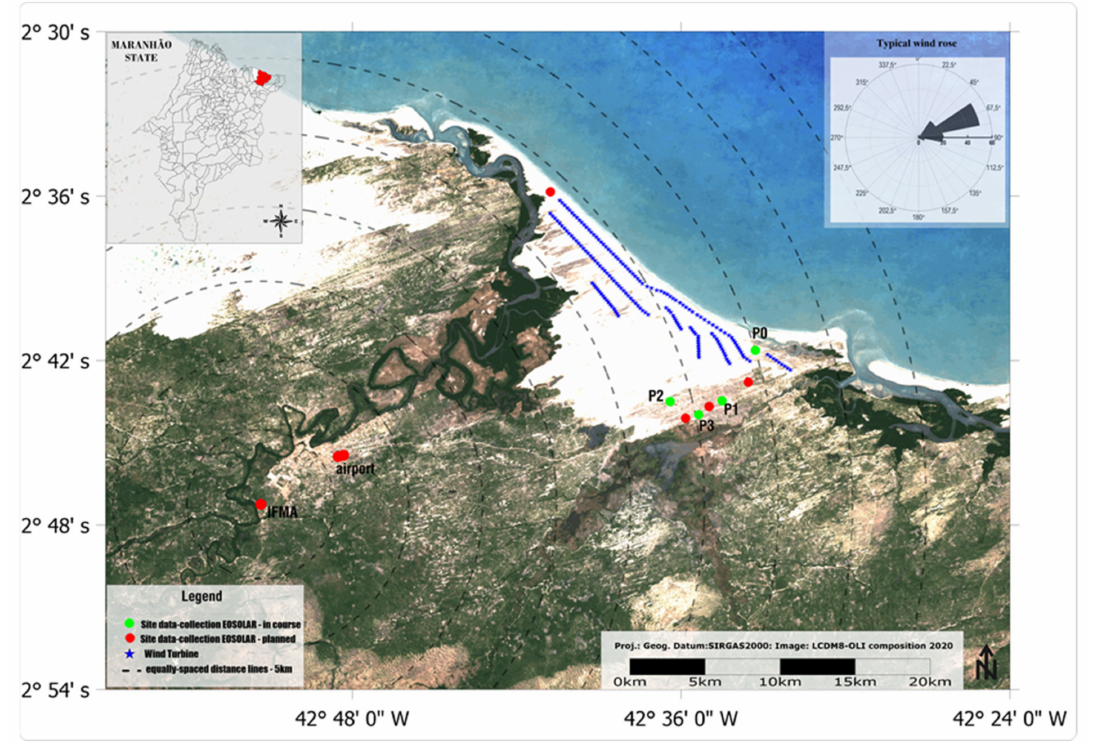
Figure 1. Landsat image of the EOSOLAR Project study site. Blue dots represent wind turbine locations; green bullets represent stations with measurements in course; red bullets are proposed sampling locations. P0 is the reference point located 1.5 km from the beach. Points located inland from P0 will be referred to as P1, P2, P3, and so forth. Black dashed lines represent equally spaced distance lines with an interval of 5